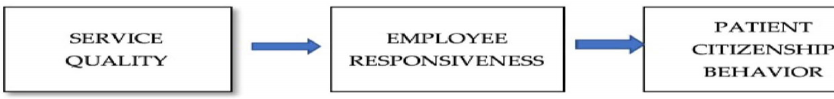
Figure 4. Mediating Effect of Employee Responsiveness.